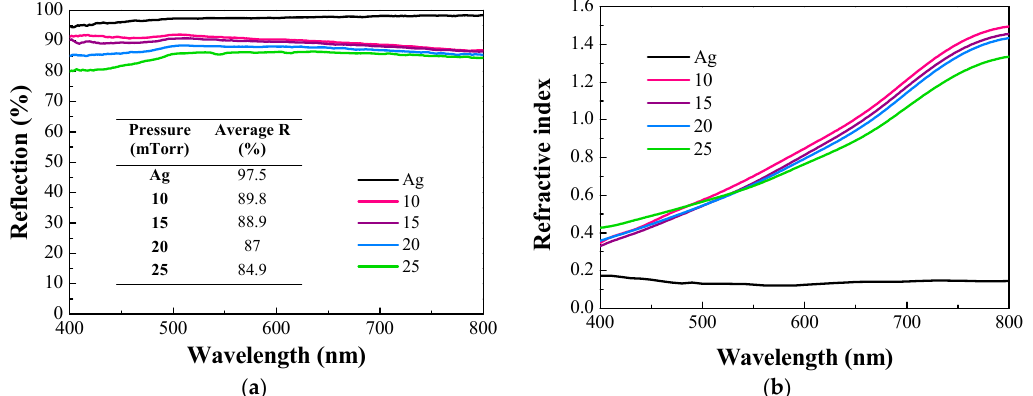
Figure 1. ( a ) Optical reflection and ( b ) refractive index of aluminum–titanium (AlTi) films prepared with different pressures.